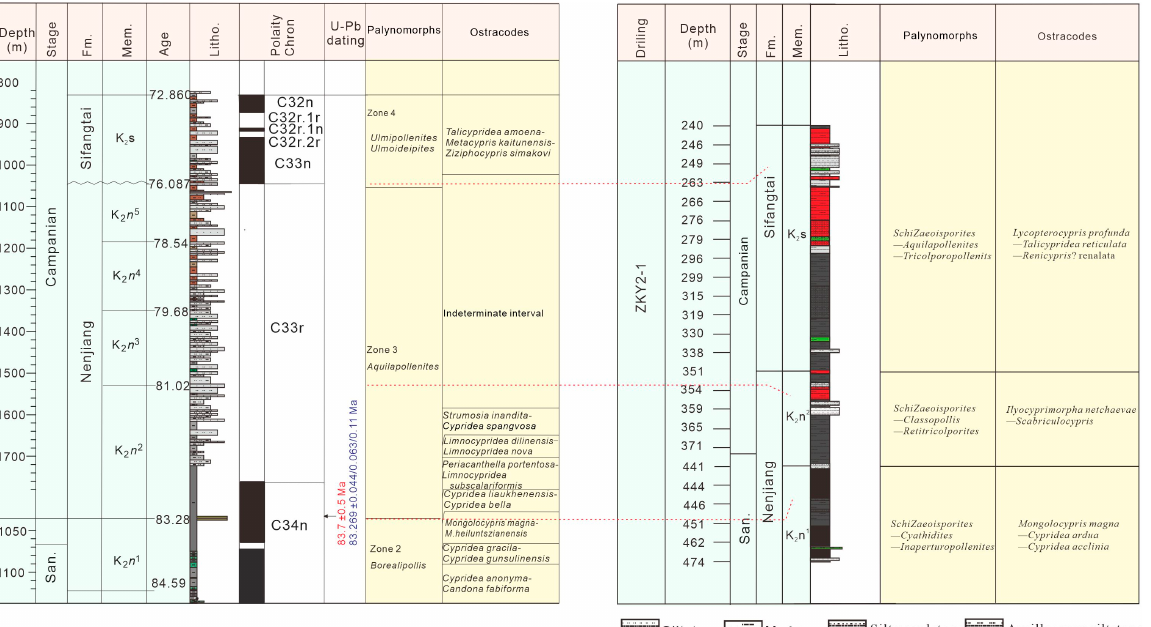
Figure 6. Stratigraphic correlation between borehole ZKY2-1 and borehole SK1. SK1 data are from reference [23].